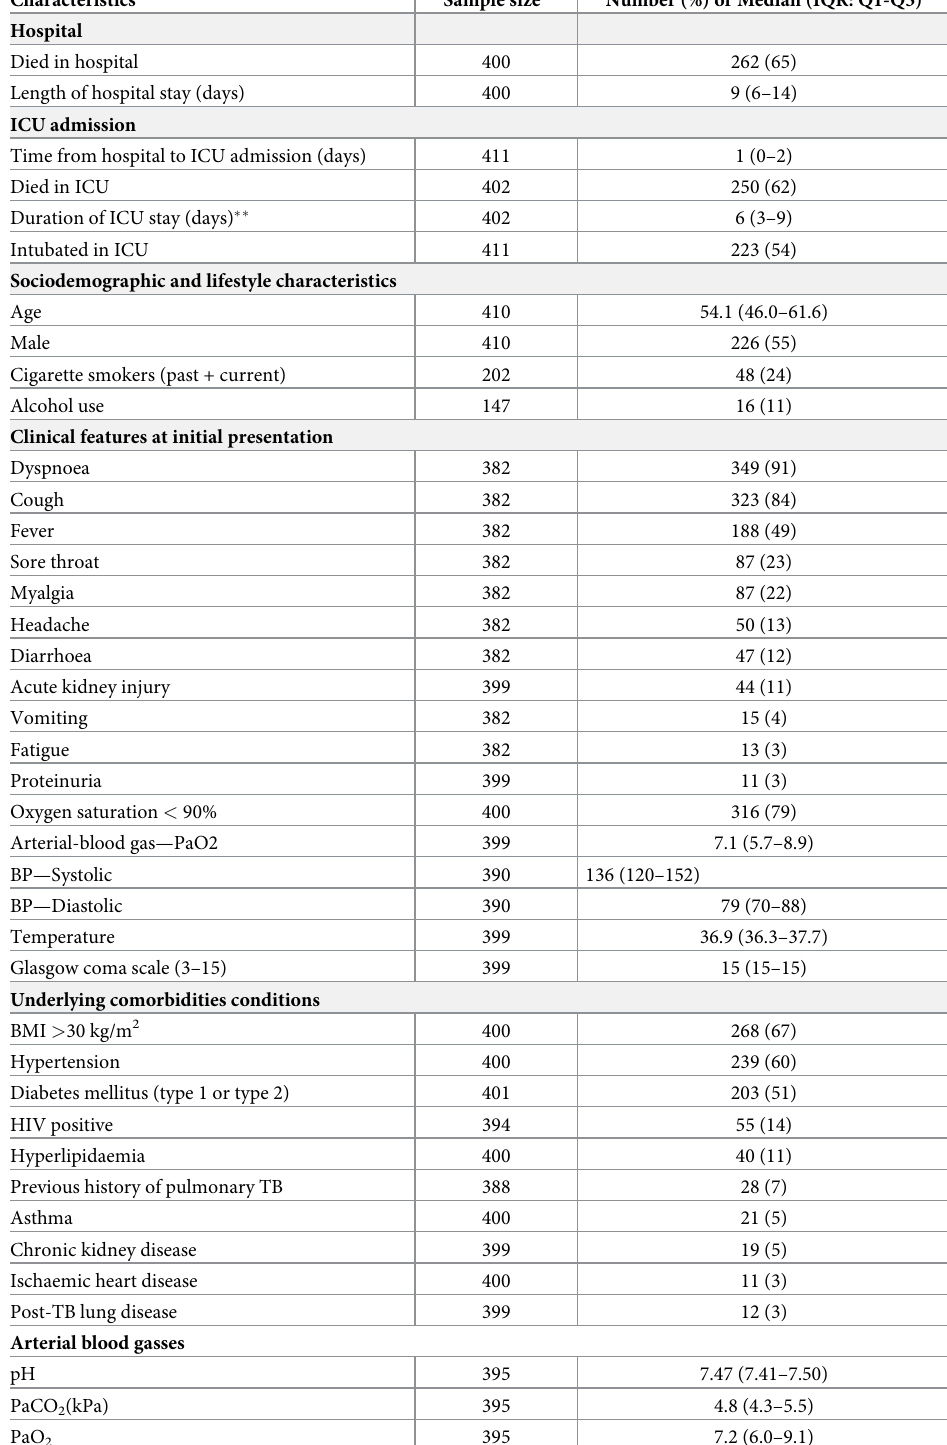
Table 1. Frequency distribution of socio-demographic and bio-clinical characteristics of COVID-19 patients admitted in the ICU.